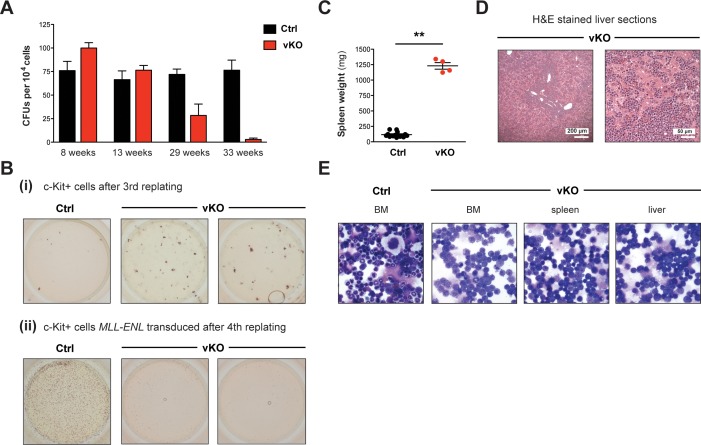
Setd1b-deficient HSPCs reveal impaired differentiation and proliferation.(A) Colony-forming unit (CFU) assay in semi-solid medium supporting myeloid differentiation. 104 cells from total BM of control and vKO mice were plated in duplicates and analyzed 9 days later. CFU numbers gradually decreased in vKO mice with increasing age, indicating progressive stem cell exhaustion. Depicted is the mean ± SD (n = 2 technical replicates per mouse). (B) Replating assays in semi-solid medium supporting myeloid differentiation. (i) 2 × 104 c-Kit+ BM cells were replated for three rounds. After the third replating, no colonies were obtained anymore in controls. However, sustained colony formation was detected in vKO samples, indicating delayed differentiation. (ii) c-Kit+ BM cells were retrovirally transduced with MLL-ENL and 2 × 104 cells were replated for four rounds. After the fourth replating, control cells were immortalized as evident from numerous appearing colonies, while vKO cells had exhausted their proliferative potential. (C) 14% of 24–33 weeks old vKO animals (n = 4) developed massively increased spleen weights (p**=0.004). The graph depicts the mean ± SEM. (D) H&E stained sections of enlarged livers in respective vKO animals showed leukemic infiltrations that destroyed normal tissue architecture. (E) May-Grünwald-Giemsa stained cytospins revealed an almost exclusive presence of myeloid blasts in BM, spleen, and liver of diseased vKO mice.